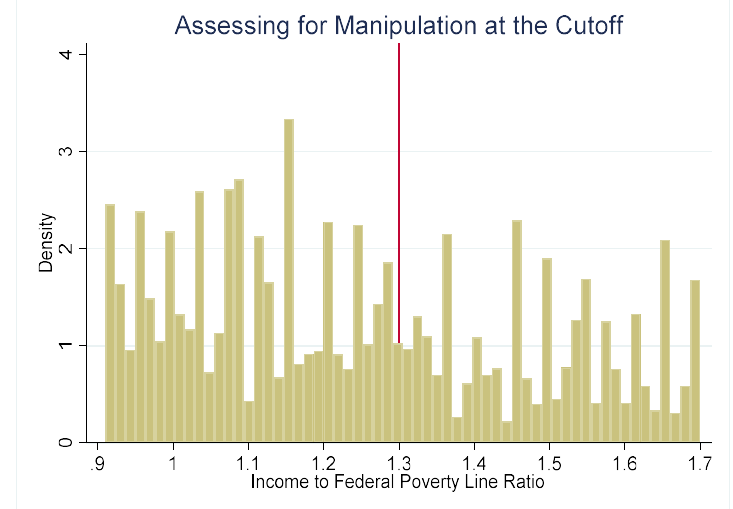
Figure 3. Assessing for Manipulation at the Cutoff. Notes: Figure 3 plots the density of cases across PIR to assess for manipulation at the 1.3 eligibility criteria. This figure suggests that there is a greater number of cases just over the 1.3 cutoff. We more closely examine this in Figure 4.